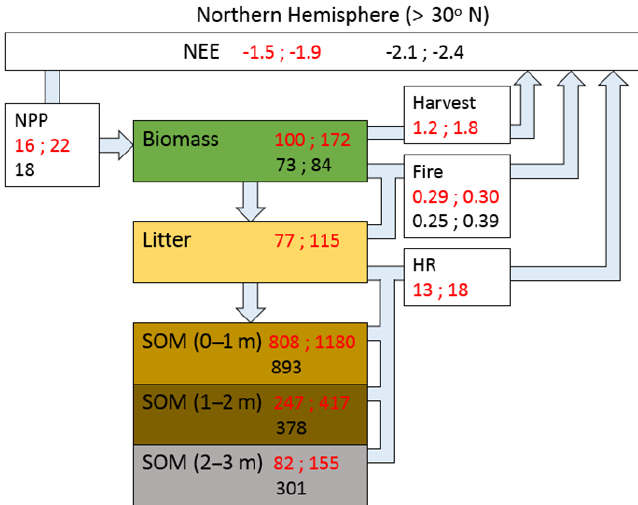
Figure 23. Annual mean land carbon fluxes (PgCyr − 1 ) and pool sizes (PgC), averaged over the terrestrial domain higher than 30 ◦ N, for the period 2000–2007. The red numbers are the results of the model forced by (left) GSWP3 and (right) CRUNCEP. The black numbers are from observation-based estimates used in the text: NPP from MODIS (NTSG), fire emissions from the (left) GFED4s and (right) GFAS datasets, harvest fluxes including crop harvest and wood product decay in the model (for simplicity, the change in wood product pools is not represented), NEE from the two atmospheric inversions (left) Jena CarboScope and (right) CAMS, forest biomass from (left) Avitabile et al. (2016) and (right) Thurner et al. (2014), and soil carbon from NCSCD (Hugelius et al., 2013) in permafrost regions and HWSD in non-permafrost